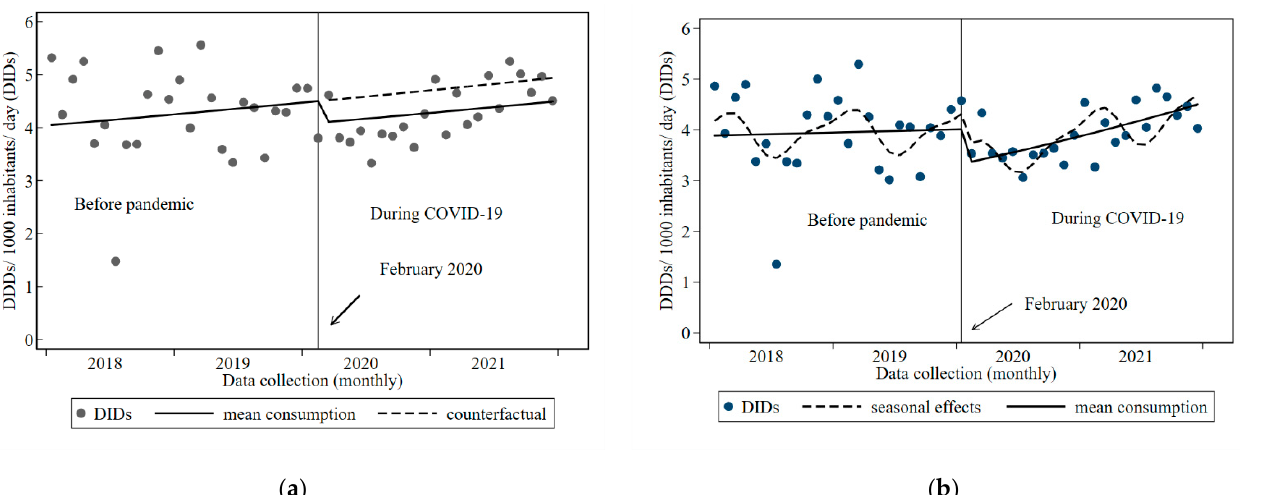
Figure 2. Outpatient antibiotic consumption at Vila Central Hospital, Vanuatu before and during COVID-19, 2018 to 2021: ( a ) Unadjusted model showing counterfactual; ( b ) Final model showing seasonal effects.